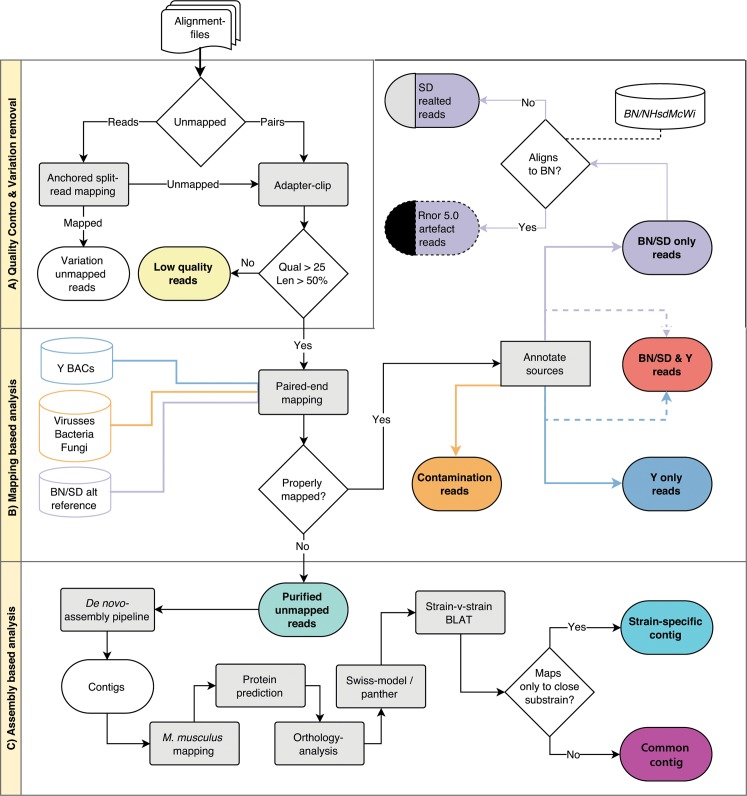
Filtering and processing workflow.Alignment files went through three stages; A) Quality Control, to remove low quality reads and reads affected by genomic variation, B) Mapping-based filtering, to identify reads derived from contaminants and regions present in alternative reference sequences and C) Identification of possible biological function and classification of common / strain-specific status.